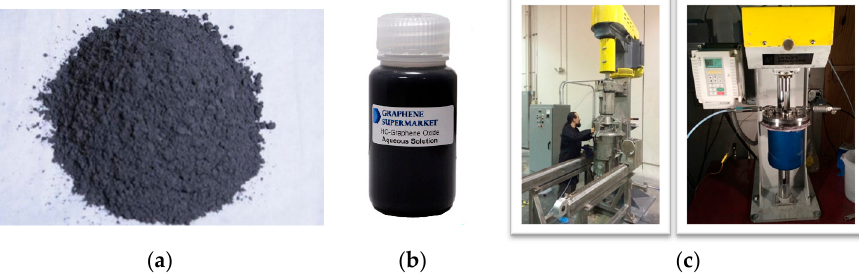
Figure 3. Graphene oxide nanoflake (GONF): ( a ) Dry GONF powder; ( b ) GONF-solution; and ( c ) the equipment for the ball milling process [16].